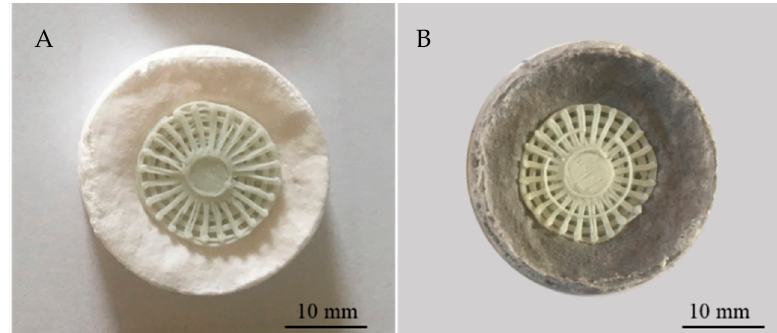
Figure 14. Digital photographs of two representative hybrid ceramic polymer samples. (A): Ag+-free PCL/BCP layer; (B): Ag + -added PCL/BCP layer.